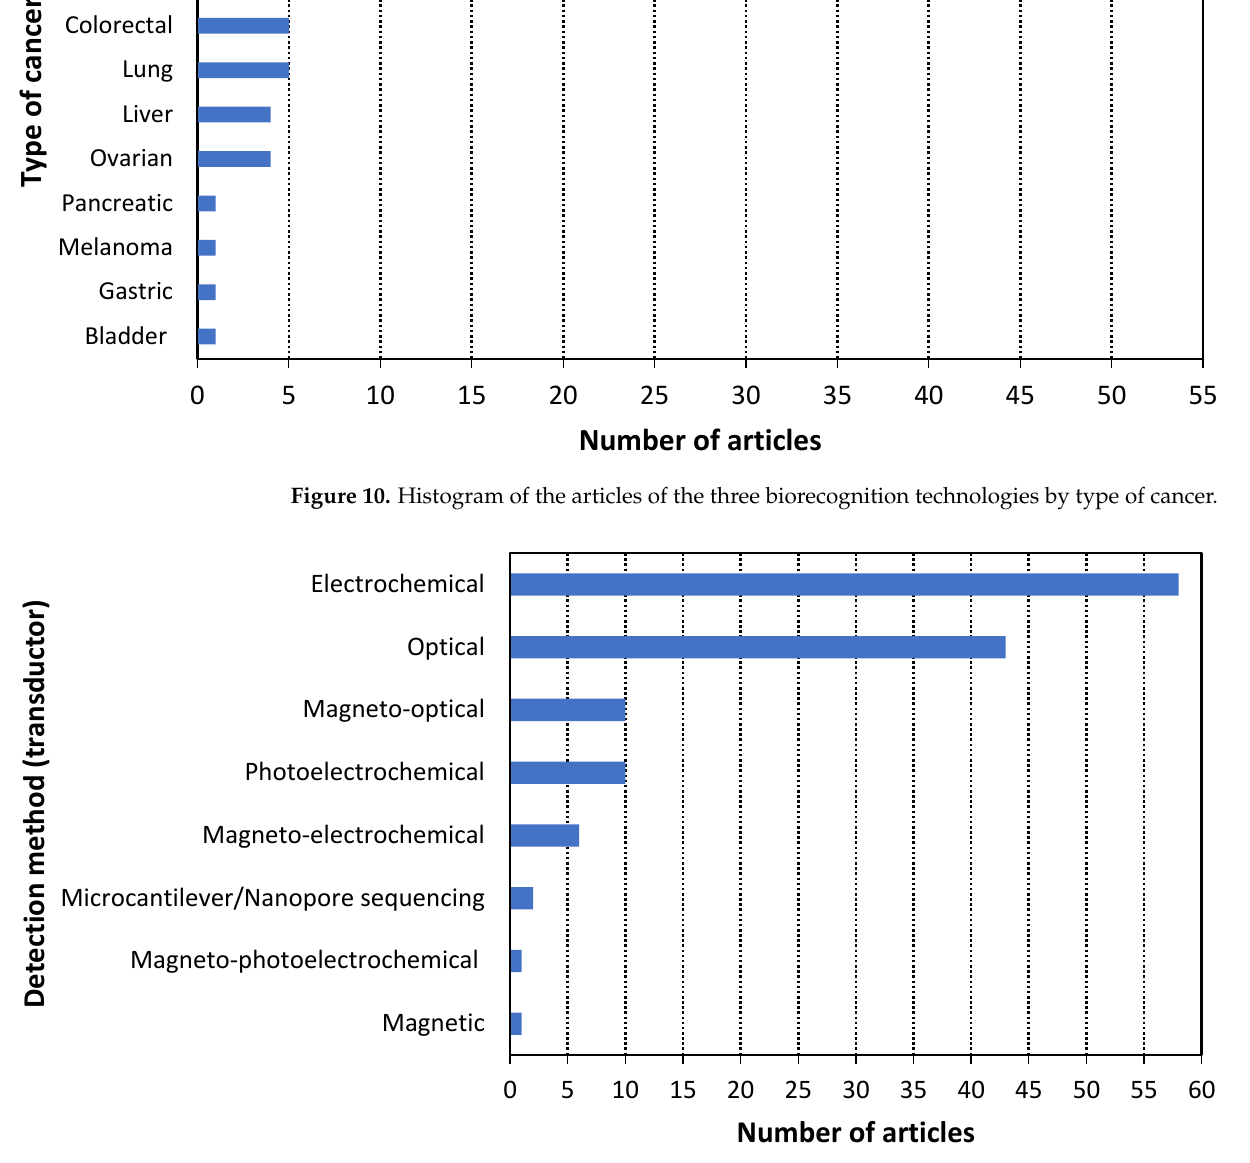
Figure 10. Histogram of the articles of the three biorecognition technologies by type of cancer.